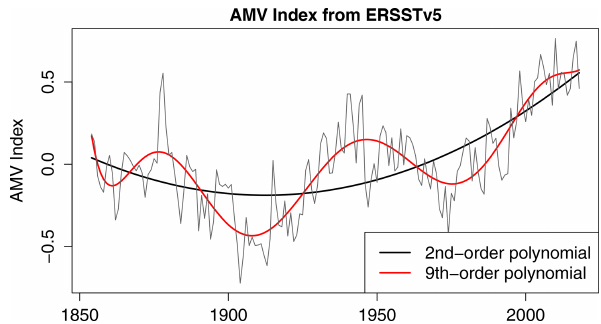
Figure 2. AMV index from ERSSTv5 (thin grey) and polynomial fits to second-order (thick black) and ninth-order (red)